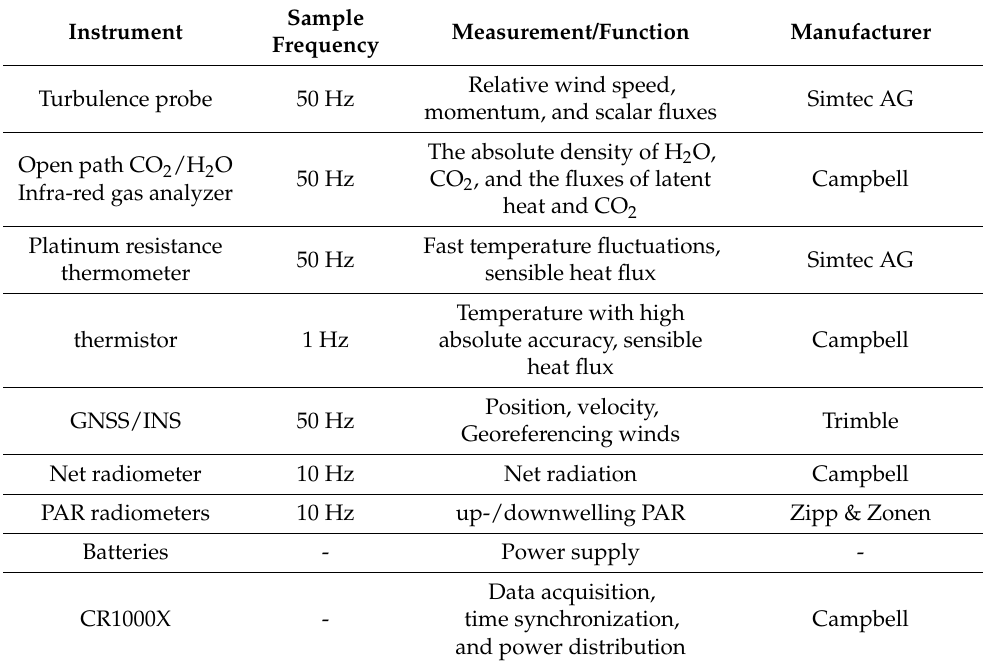
Table 2. The function and sampling frequency of the scientific payload instrumentations.